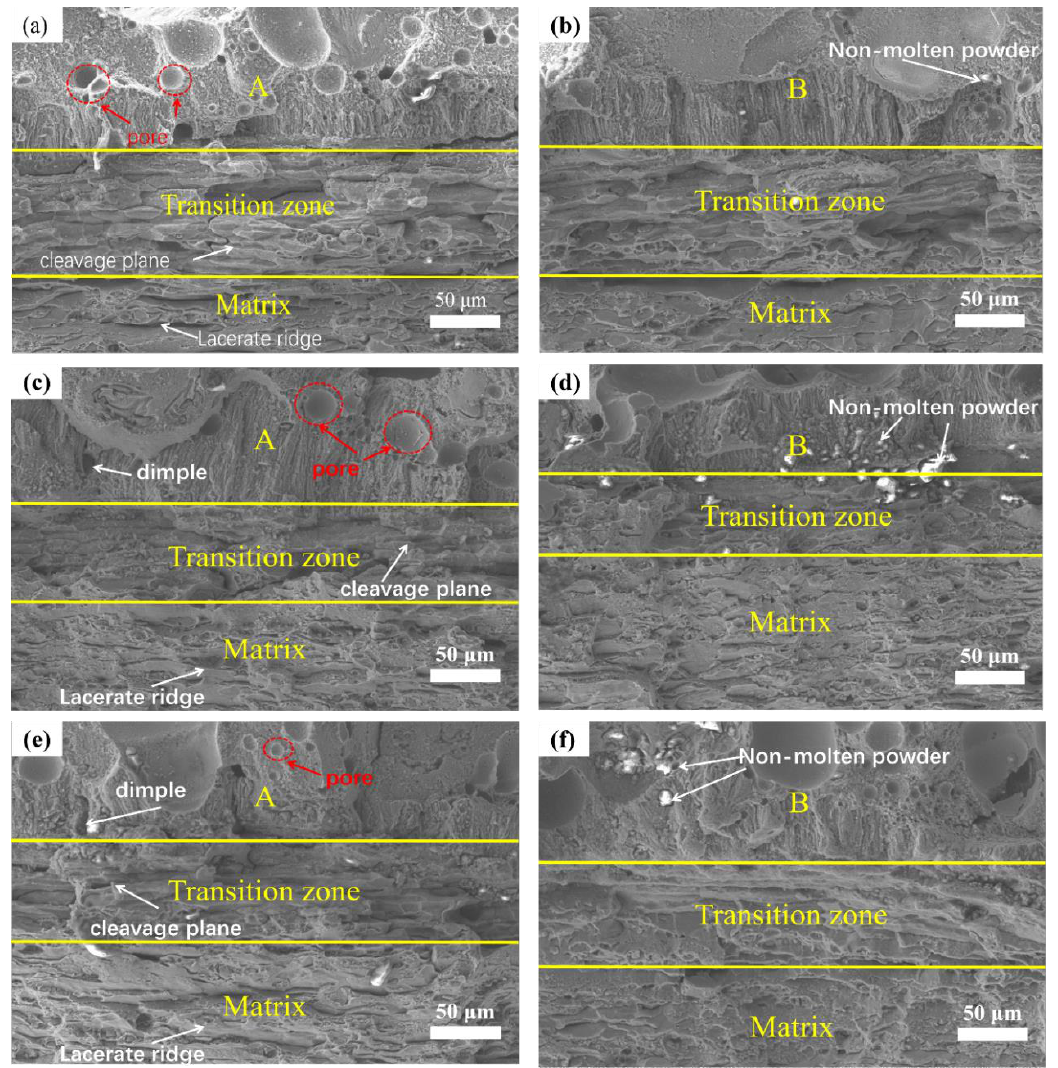
Figure 11. The fracture surfaces of the samples with different biomimetic spacings in regions A and B: 1.5mm ( a , b ), 2.5mm ( c , d ) and 3.5mm ( e , f ).